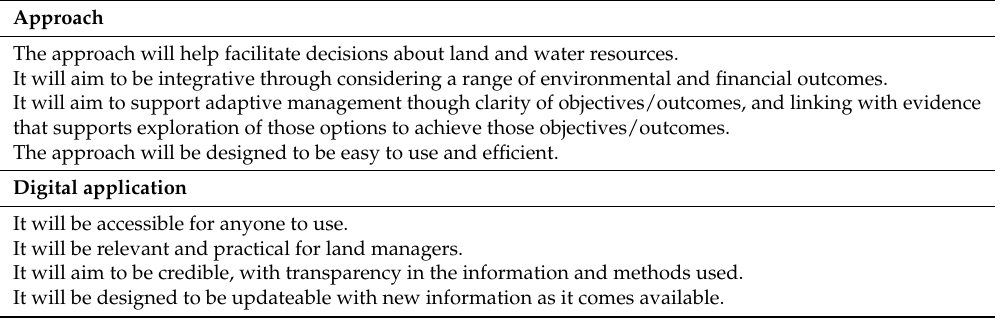
Table 3. Integrated general principles for application development.